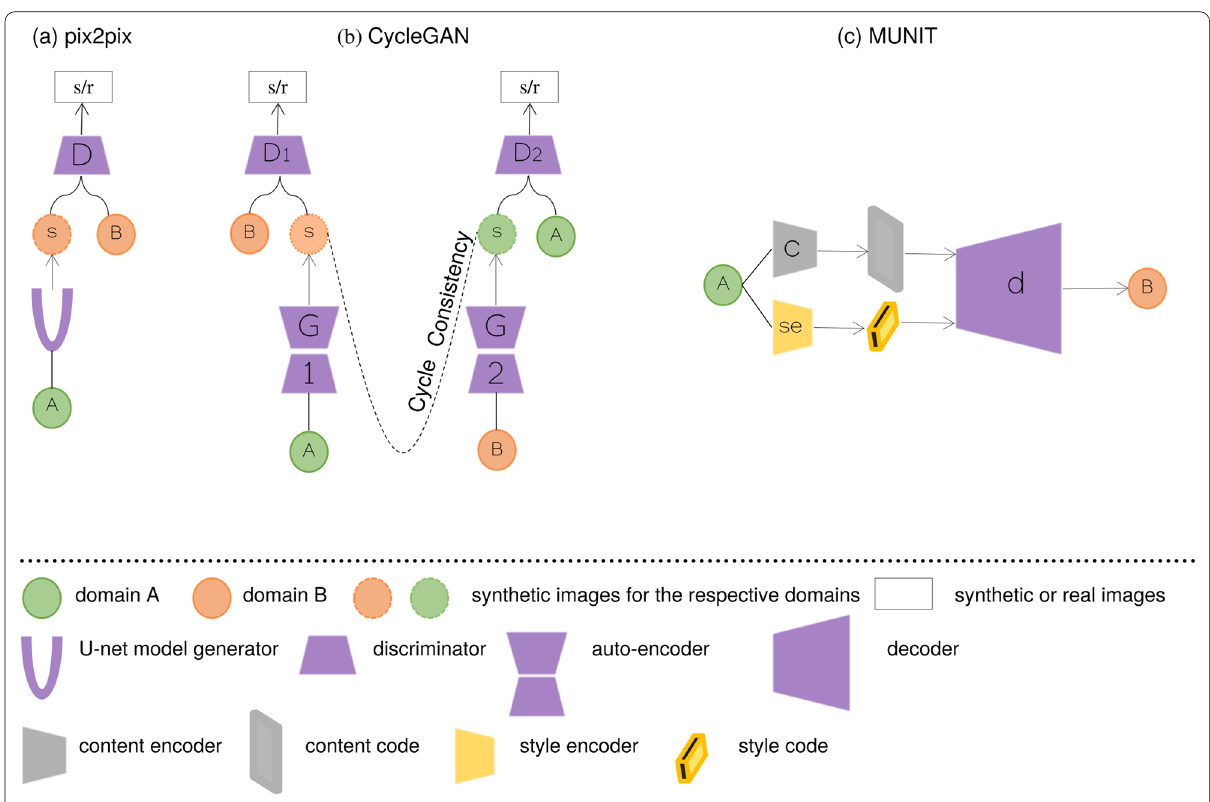
Fig. 6 Generative architectures for image-to-image translation. a The pix2pix is an extension of the conditional GAN architecture that provides control over the generated image. The U-net model generator translates images from one domain to another and through skip connections the low-level features are shared. The discriminator judges whether a patch of an image is real or synthetic instead of judging the whole image, while the modified loss function allows the generated image to be plausible in the content of the target domain. b CycleGAN is designed specifically to perform image-to-image translation on unpaired sets of images. The architecture uses two generators and two discriminators. The two generators are often variations of autoencoders where they take as input an image and output an image as output; the discriminator, however, takes as input an image and outputs one single value. In the case of CycleGAN, a generator gets further feedback from the other generator. This feedback confirms whether an image generated by a generator is cycle consistent, meaning that applying successively both generators on an image should produce a similar image. c In the MUNIT architecture, the image representation is decomposed into a content code and style code through the respective encoders. The content code and style code is recombined to translate an image to the target domain. By sampling different style codes the model is capable of producing diverse and multimodal